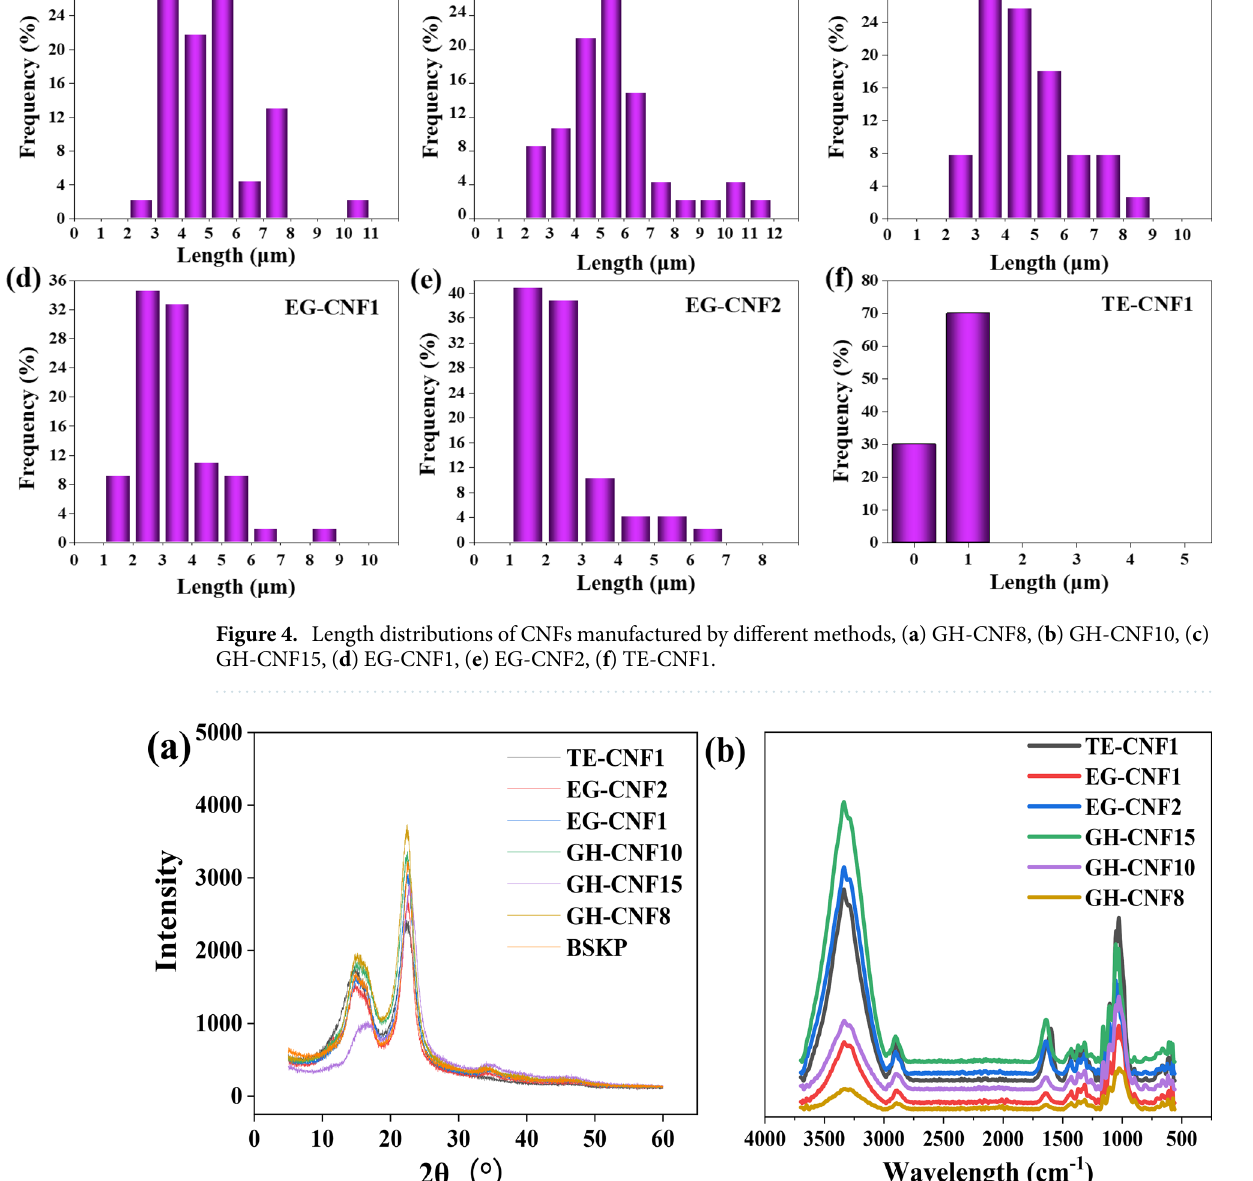
Figure 5. ( a ) XRD spectra of TE-CNF1, EG-CNF1, EG-CNF2, GH-CNF8, GH-CNF10, and GH-CNF15; ( b ) FTIR spectra of GH-CNF8, GH-CNF10, GH-CNF15, EG-CNF1, EG-CNF2, and